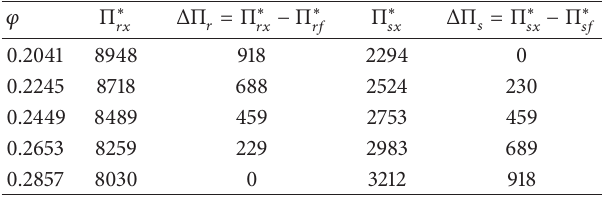
Table 2: The profits and their increments of the retailer and supplier after